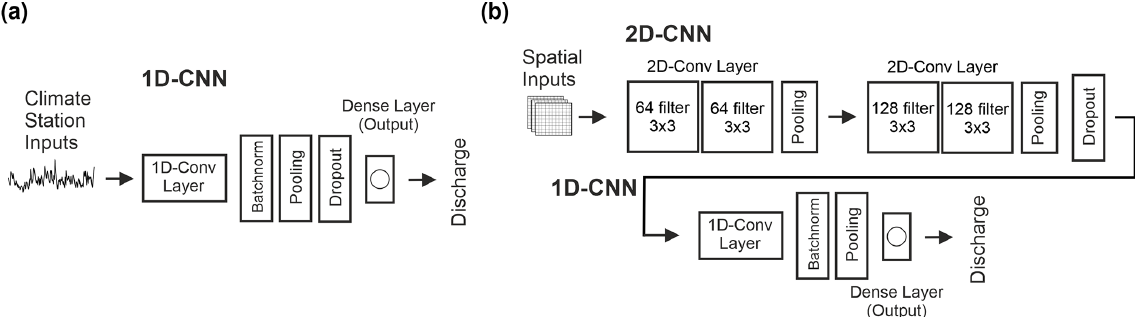
Figure 2. Model structures applied for modeling karst spring discharge based on climate station data (a) and gridded meteorological input data (b) . Flatten layers are not